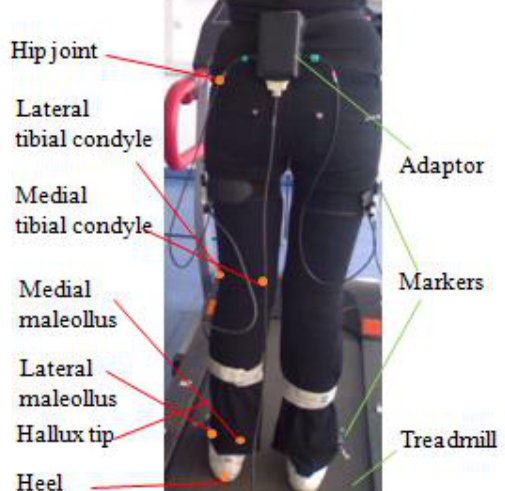
Fig. 1. Equipment setup and anatomical landmarkers of the